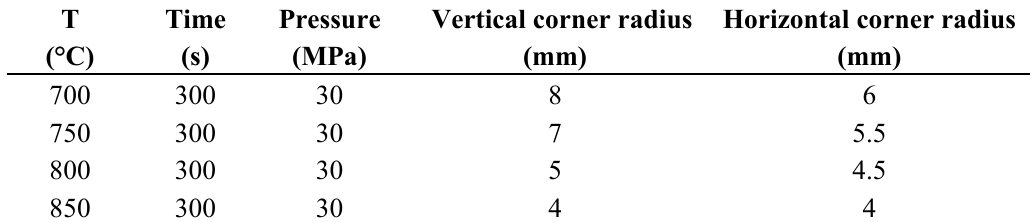
Table 3. Corner radii at various temperatures in 300 s.